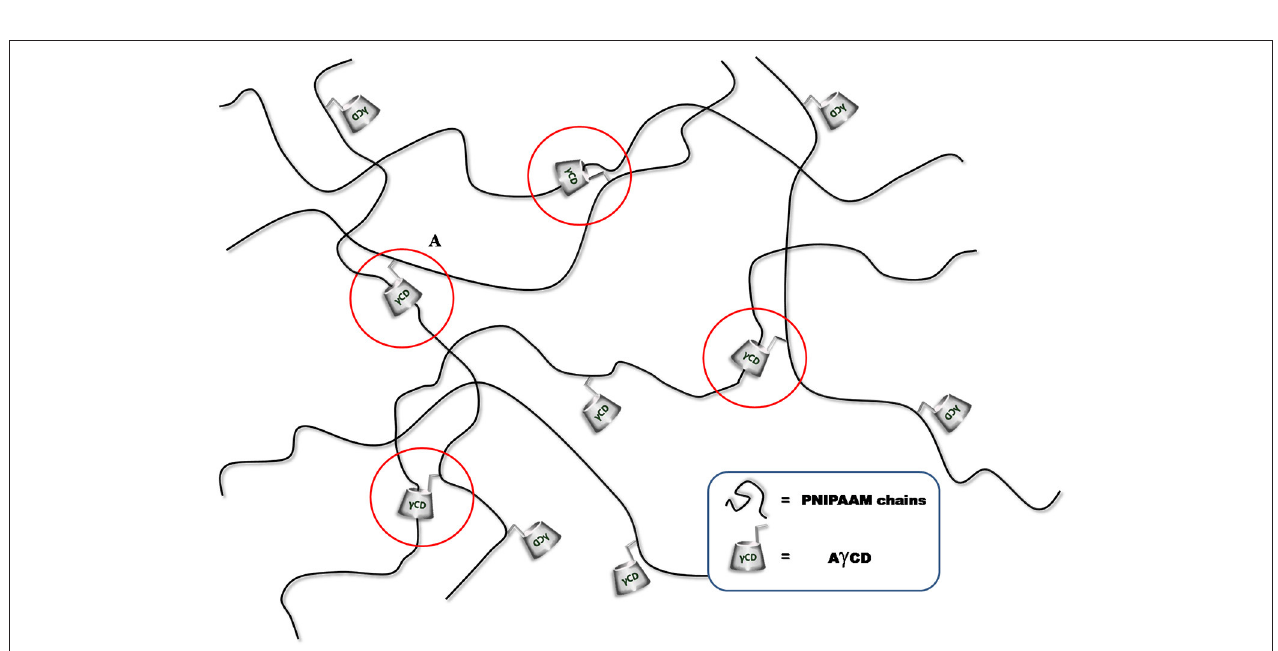
FIGURE 2 | Schematic illustration of sliding crosslinking exerted by A γ CD.